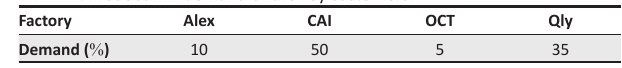
FIGURE 2: Current distribution network design for El-Obour city. TABLE 1: Product mix demand of the key